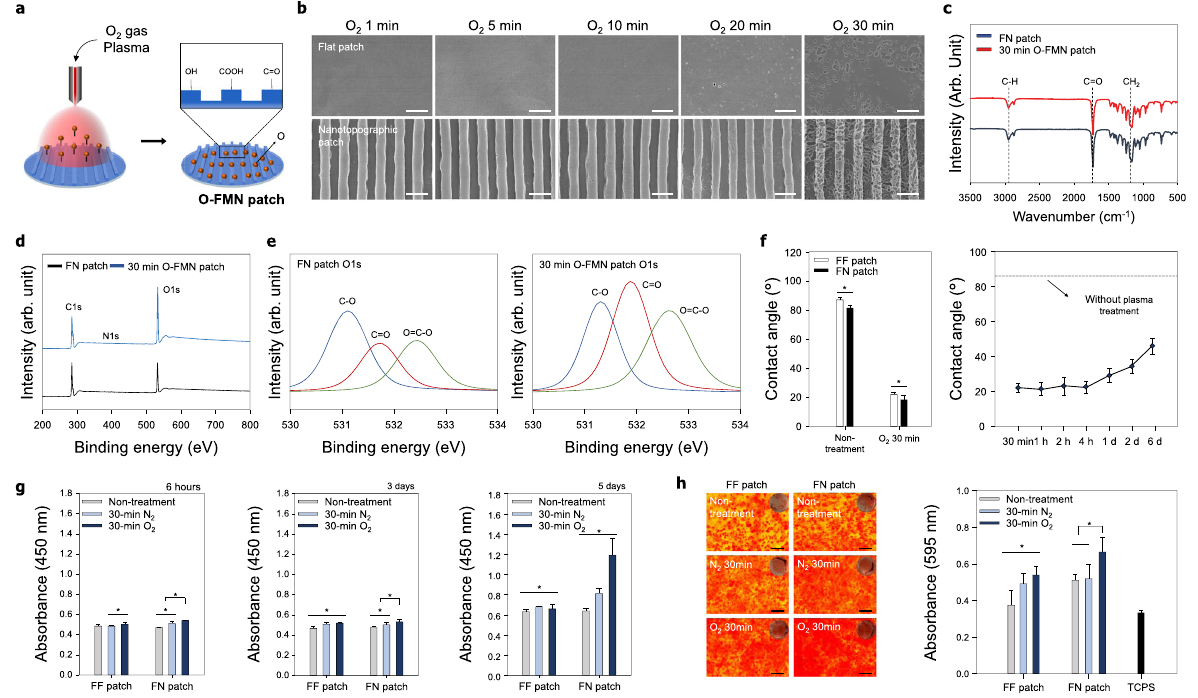
Fig. 3 Characterization of the O-FMN patch and effect of the O-FMN patch on cellular behaviors. a Schematic of plasma surface modi fi cation using O 2 plasma reaction gas on the surface of the FN patch. b SEM images of the O-FMN patch under various treatment times. The surface topography of the O-FMN patch showed the generation of nanopore structures without damage to the aligned nanotopography. Scale bars = 2 µm. c FT-IR analysis of the 30-min O-FMN. d XPS survey scans and e high-resolution O1s XPS spectra of FN patches and 30-min O-FMN patches. f Water contact angle measurements ( n = 10 for each group) and wettability recovery ( n = 5) on surfaces of the O-FMN patch. g Attachment and proliferation of cells on O-FMN patches ( n = 6 for each group). After 5 days of cell culture, cell proliferation was higher on the 30-min O-FMN than on the 30-min N-FN. h Effect of O-FMN patches on the osteogenic mineralization of tenocytes. Alizarin Red staining revealed higher calcium expression levels on the 30-min O-FMN patches than on other samples and the tissue culture polystyrene